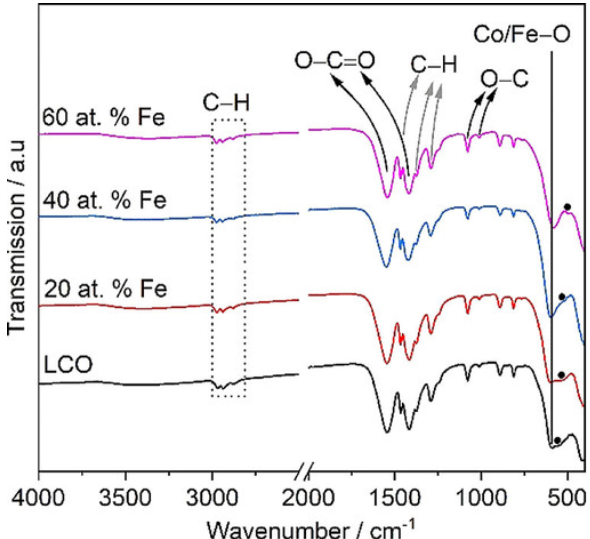
Figure 8. FTIR spectra of perovskite nanoparticles, exposing the C-H, O-C=O, O-C, and Co/Fe-O functional groups. Dots represent a secondary band related to the last functional group [27] . Reproduced with permission from Alkan, B., et al., ChemElectroChem; published by Chemistry Europe, 2019.